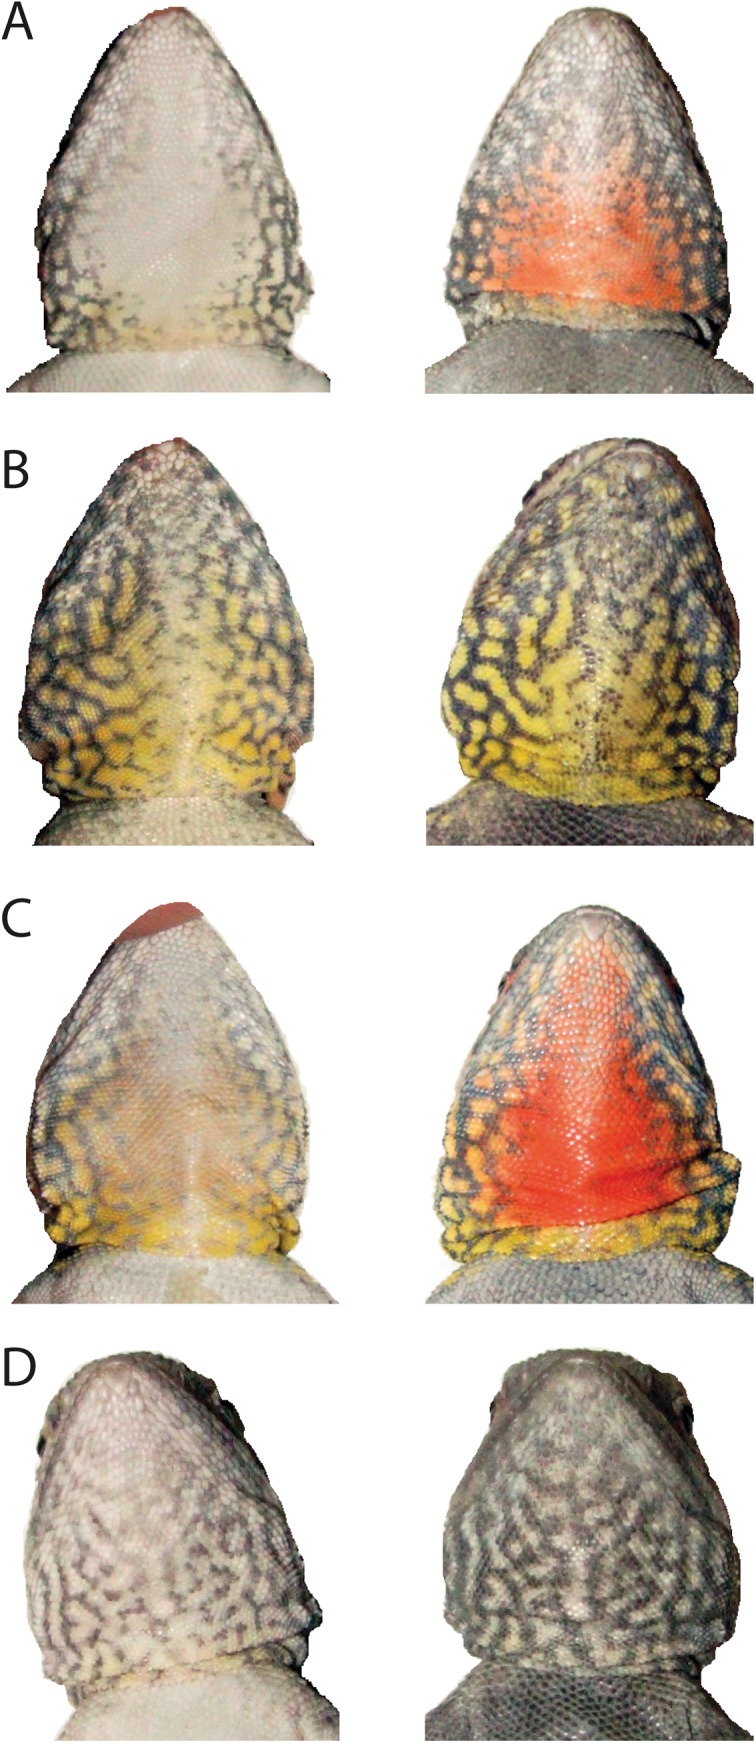
Effect of testosterone on female throat colour expression for each morph.Pre-testosterone implantation (left) versus same lizard at peak of morph expression (right): A) orange, B) yellow, C) orange+yellow, D) grey.